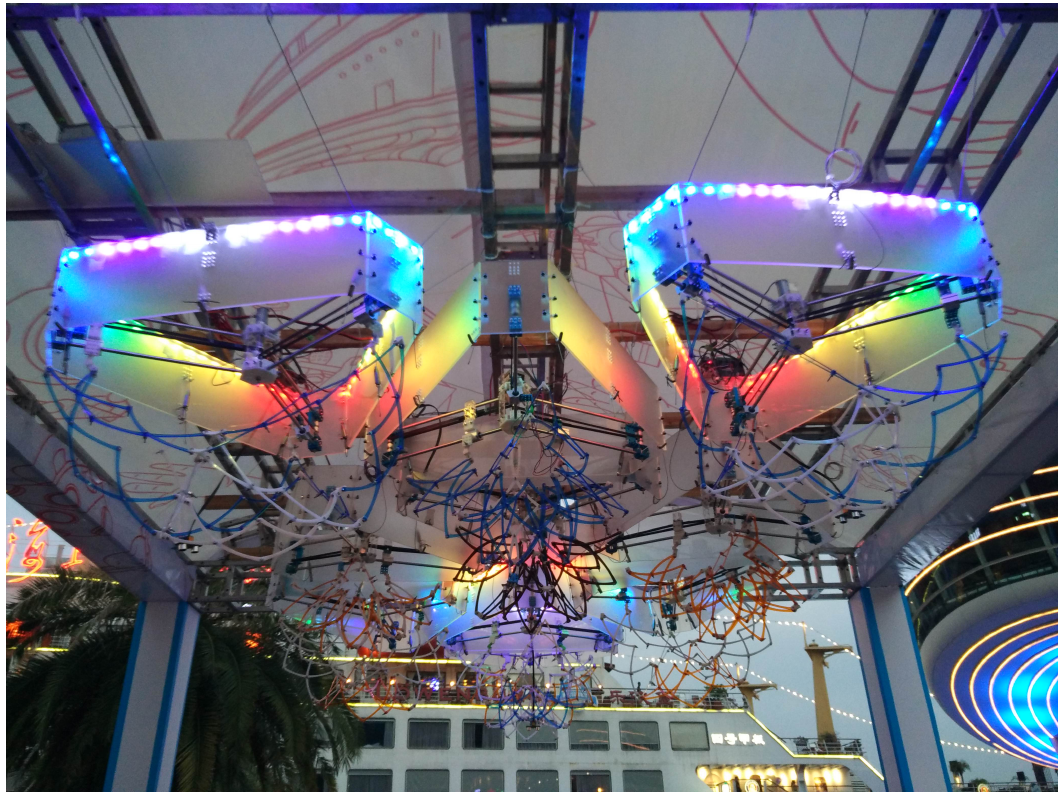
Figure 11. Full-scale RCCE prototype: Installation of RCCE on site at Shenzhen MakerFaire